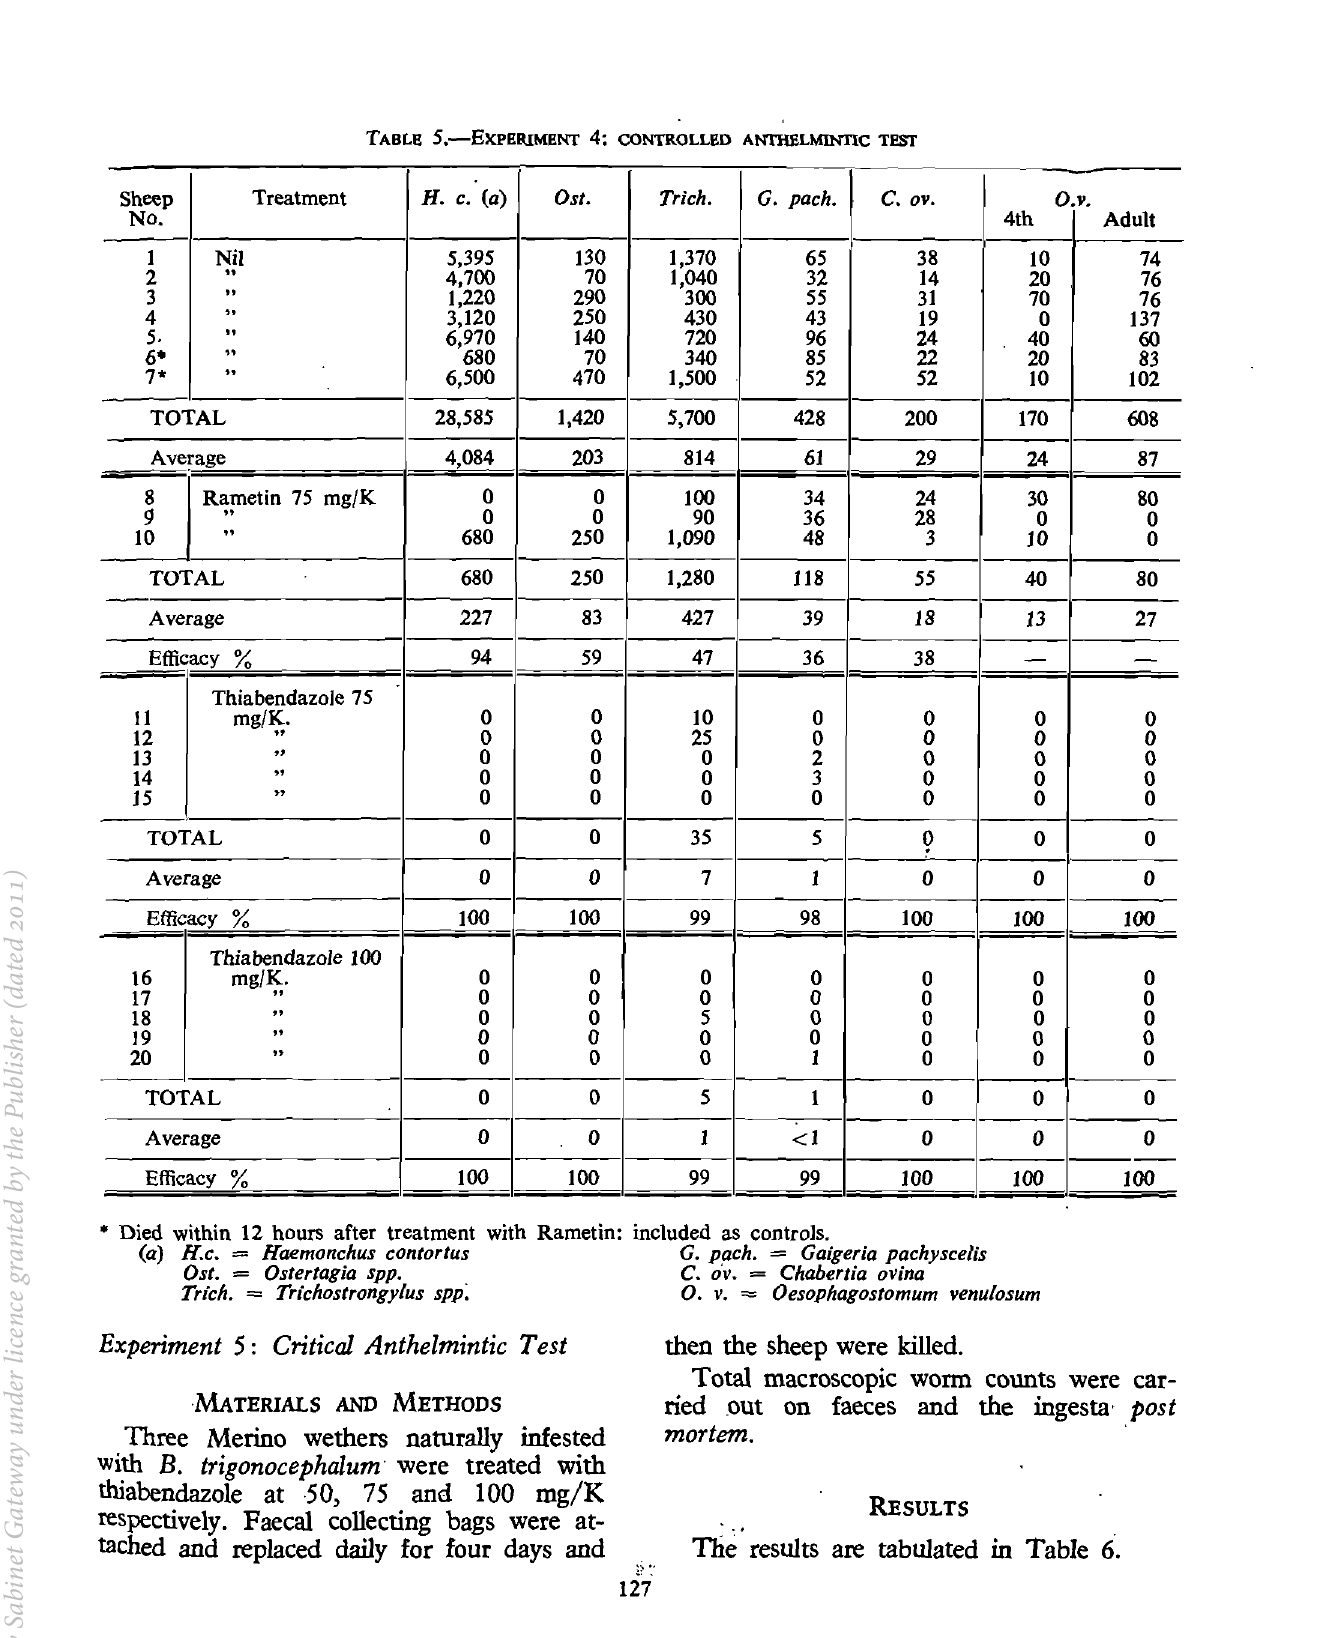
TABLE 5.-ExpI!RIMI!NT 4: CONTROLLI!D ANTHJ!LMINTlC TI!ST